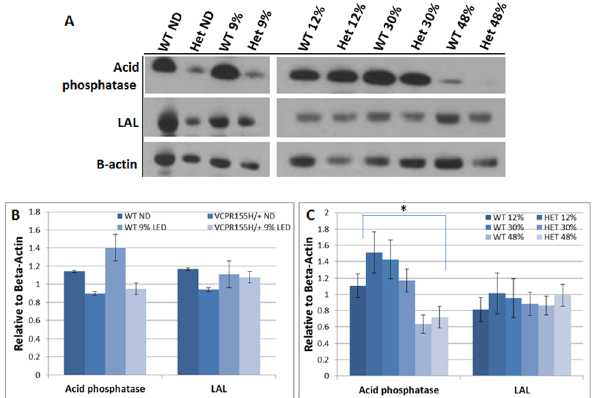
Fig 5. Effects of LED on the expression of lysosomal enzymes in the quadriceps of WT and VCP R155H/+ mice on normal and different lipid-enriched diets. (A) Western blot analyses of protein expression levels of acid phosphatase, lysosomal acid lipase in WT and VCP R155H/+ knock-in animals on varying ND (6%), 9%, 12%, 30%, and 48% lipid-enriched diets (LED). (B,C) Densitometry analyses of acid phosphatase and LAL from various diets relative to loading control (Beta-actin). Statistical significance is denoted by * P (cid:1) 0.05. The number of mice analyzed per experiment is 8 – 10.